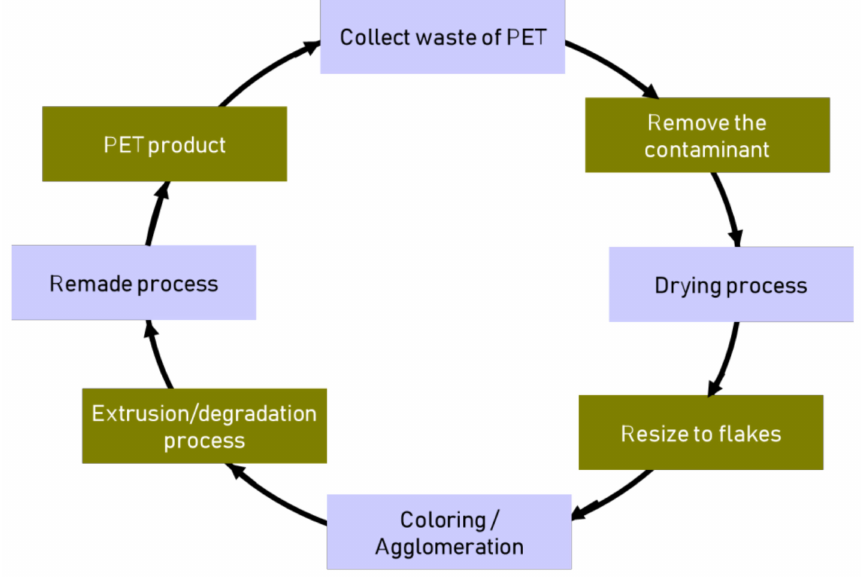
Figure 1. Scheme of the conventional mechanical process of PET